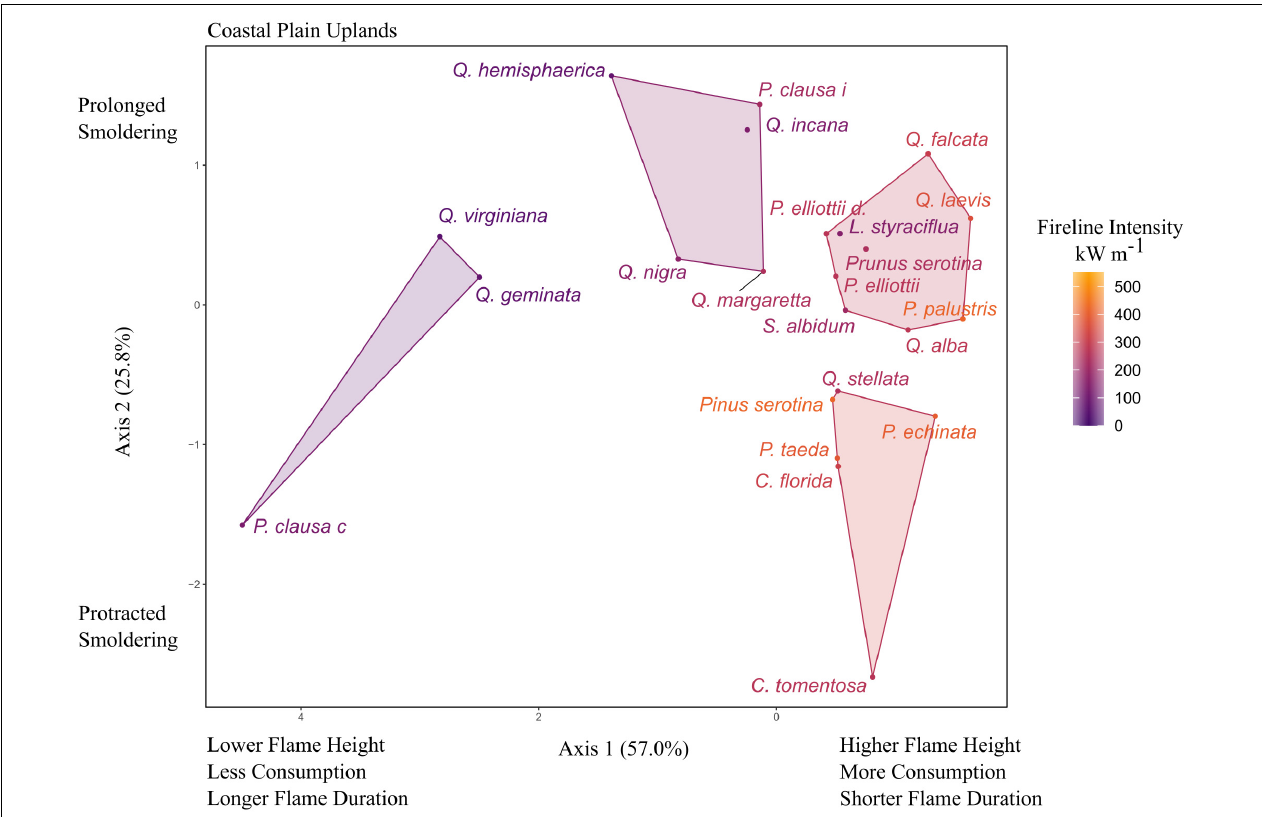
FIGURE 2 | Principal components analysis (PCA) for flammability of tree litter in coastal plain uplands of the southeastern United States. Axis 1 was inverted to be consistent with the other figures (increased flame height and consumption on the right). Species codes and mean values listed in Table 1 and Supplementary Table 1